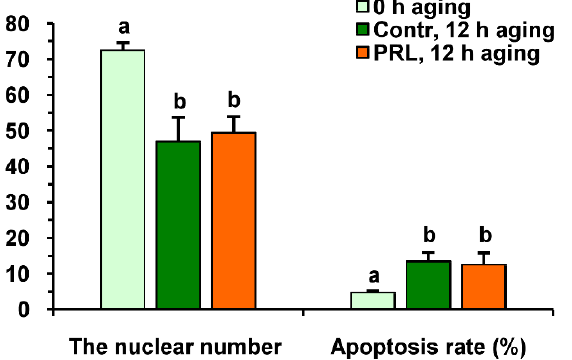
Figure 12. The quality of embryos derived from in vitro-matured bovine CEOs aged for 12 h in the absence or in the presence of PRL (50 ng/mL). Data represent means ± SEM for 46 (0 h of aging), 15 (control, 12 h of aging) and 31 (PRL, 12 h of aging) blastocysts on day 7 after IVF. Means marked with different letters differ significantly (at least p < 0.05).